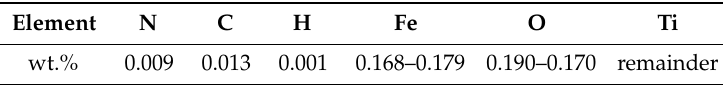
Table 1. The chemical composition of the Ti grade 2 substrate, wt.%.